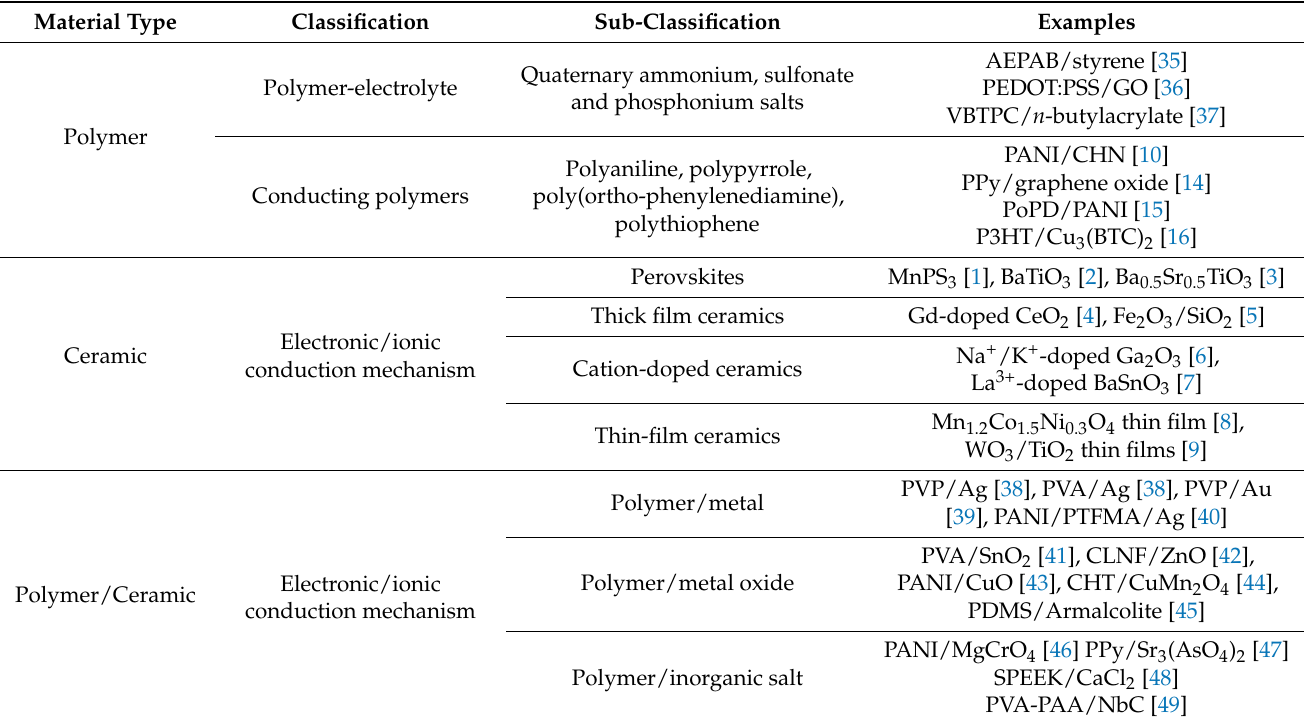
Table 2. Various types of resistive humidity